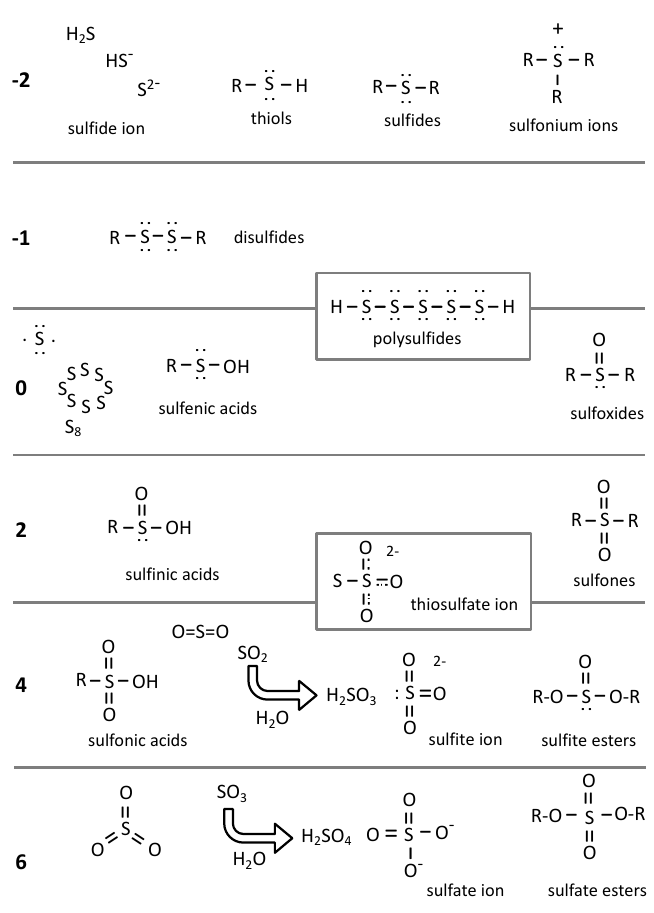
Figure 2. Oxidation state of sulfur compounds. Oxidation states of sulfur are indicated on the left by bold numbers. For the zero state, the outer electronic layer of sulfur is schematized top left. An example of polysulfide is shown boxed over columns − 1 and zero; the two sulfur atoms at the edges are at state − 1 and in the center at state 0. For states 4 and 6, we show the hydration products of sulfur dioxide and sulfur trioxide, leading to the formation of sulfite and sulfate ions, respectively. Thiosulfate is boxed between states 2 and 4. This figure is inspired by Chemistry Libretexts Thiols and sulfides contributed by William Reusch: https://chem.libretexts.org/Bookshelves/Or- ganic_Chemistry/Supplemental_Modules_(Organic_Chemistry)/Thiols_and_Sulfides) accessed on 7 January 2022.